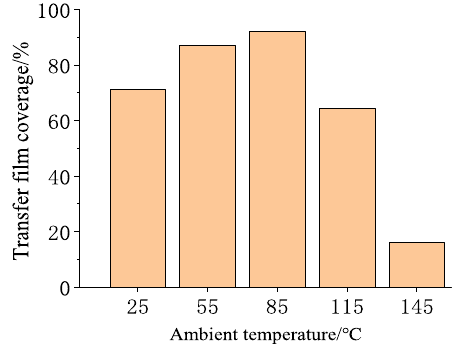
Fig. 9. Coverage of PTFE transfer fi lm on the surface of the